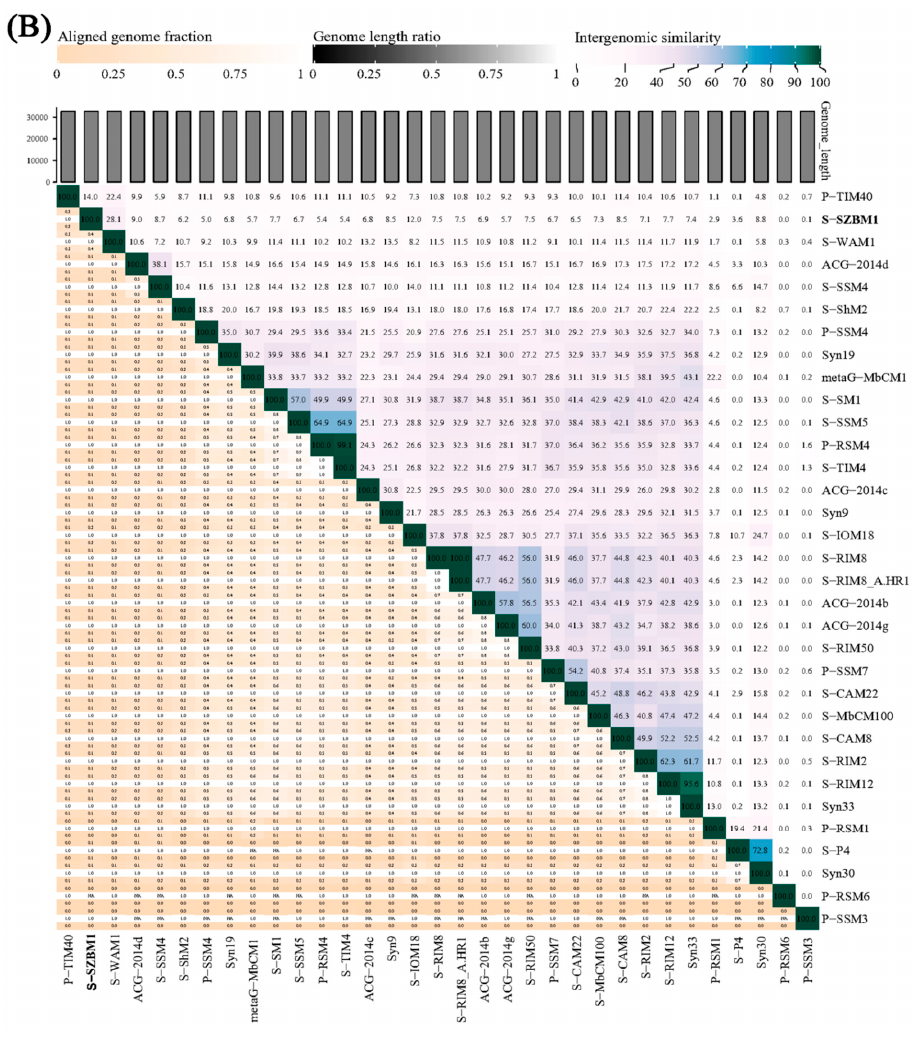
Figure 3. ( A ) Phylogenetic analysis showing the evolutionary relationship and taxonomy of cyanophage S-SZBM1. The GBDP phylogenetic tree was constructed using VICTOR based on complete amino acid profiles of compared phages. The numbers near branches of the phylogenetic tree are GBDP pseudobootstrap support values from 100 replications. The hosts, G+C content, genus cluster information, and genome size of these phages were obtained from the NCBI and the ICTV. ( B ) Heatmap generated by VIRIDIC incorporating intergenomic sequence similarities (right half) and alignment indicators (left half) for cyanophage S-SZBM1 and its most closely related 32 cyanophages.